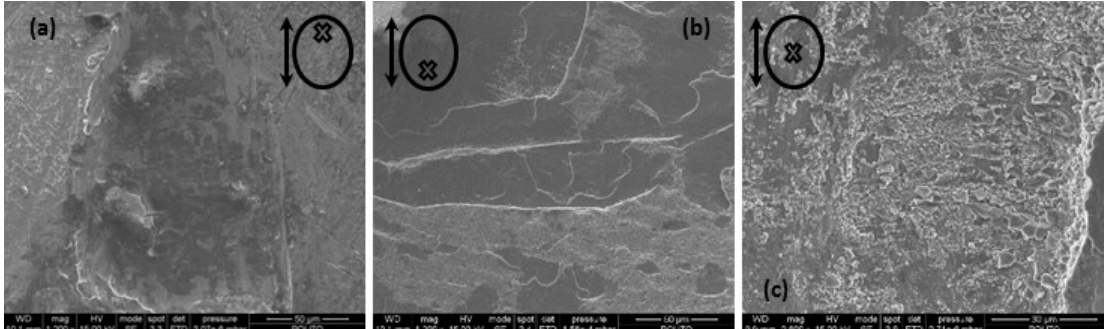
Figure 11. SEM, crack on the oxide layer: ( a ) pair 03—flat; (b) pair 07—sphere; (c) shattered oxides pair pair 01—flat.